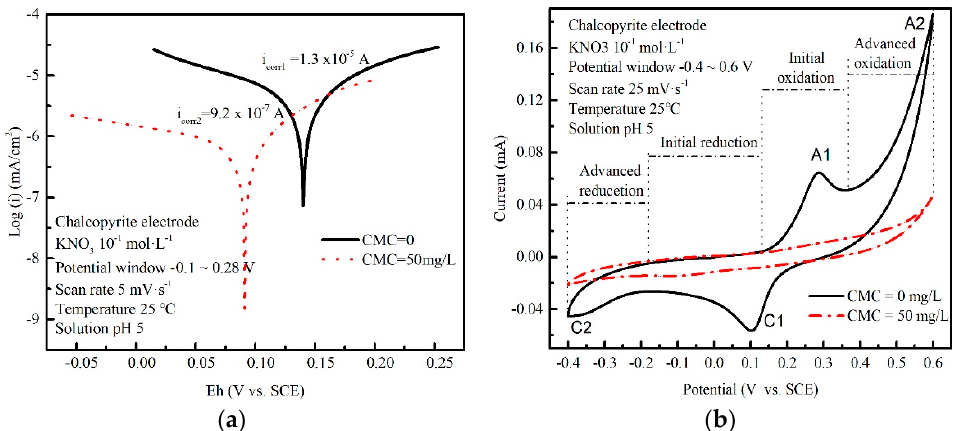
Figure 6. ( a ) Tafel plots and ( b ) cyclic voltammetry diagrams of chalcopyrite in the absence (black) and presence (red) of CMC.